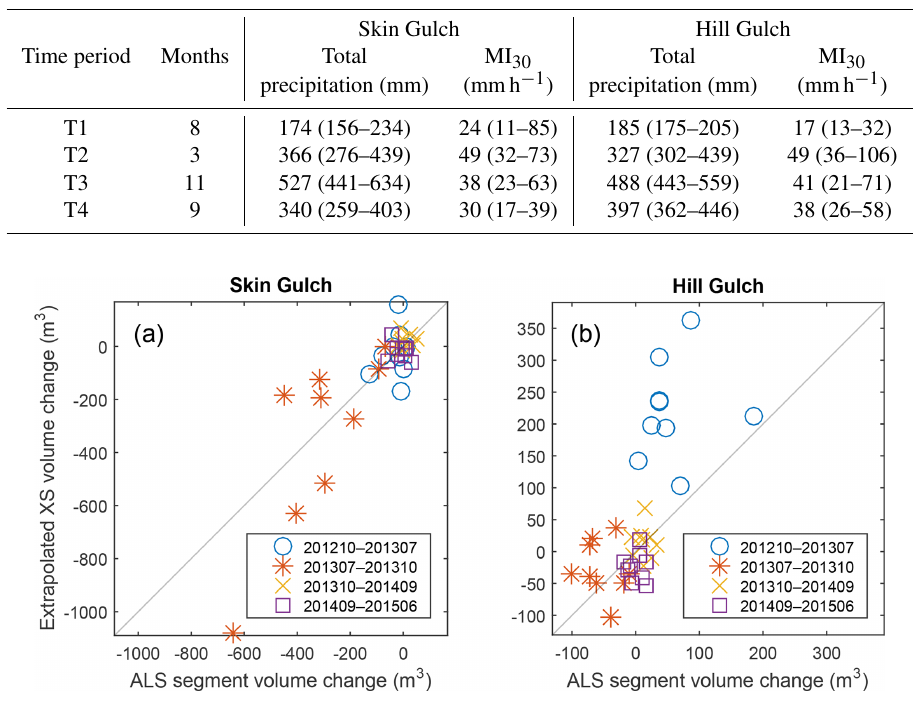
Figure 4. Plots of the extrapolated cross section (XS) volume changes versus the corresponding ALS segment volume changes for (a) Skin Gulch and (b) Hill Gulch. Diagonal lines are the 1 : 1 relationship, and the different symbols in each plot represent the different time periods.